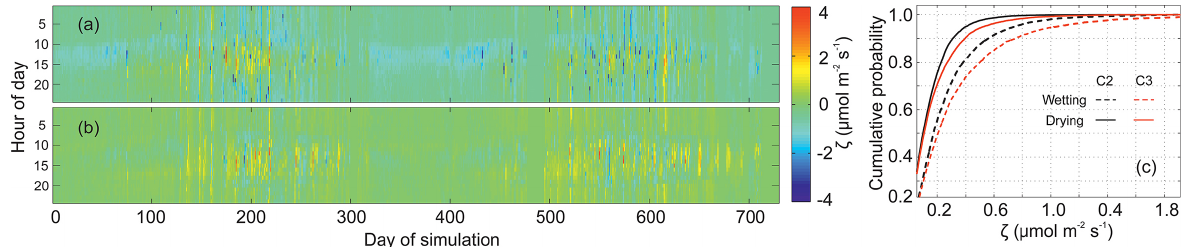
Figure 7. Diurnal patterns of biases ( ζ) in the simulated hourly F S for lichen-crusted soils using opaque (a) and transparent chambers (b) , and the cumulative probability of the biases during wetting and drying periods (c) during 2013–2014. The wetting period included the rainy days and a 1-day period after each rainfall. The drying period included the rest of the years other than the wetting